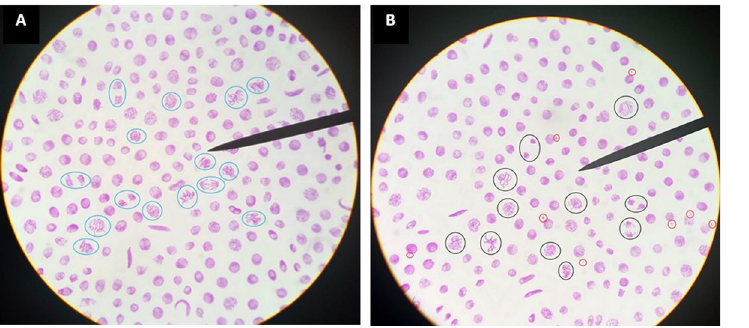
Fig 1. Vicia faba cells in proliferation: (A) non genotoxic water source slide, mitotic cells are circled in blue; (B) genotoxic water source slide, mitotic cells are circled in black and micronuclei are circled in red.